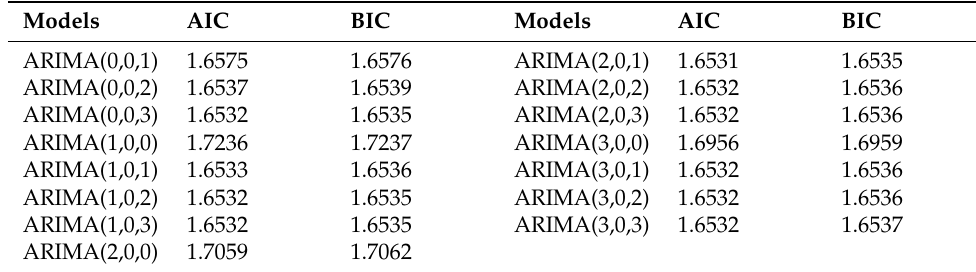
Table 1. AIC and BIC values for each model.